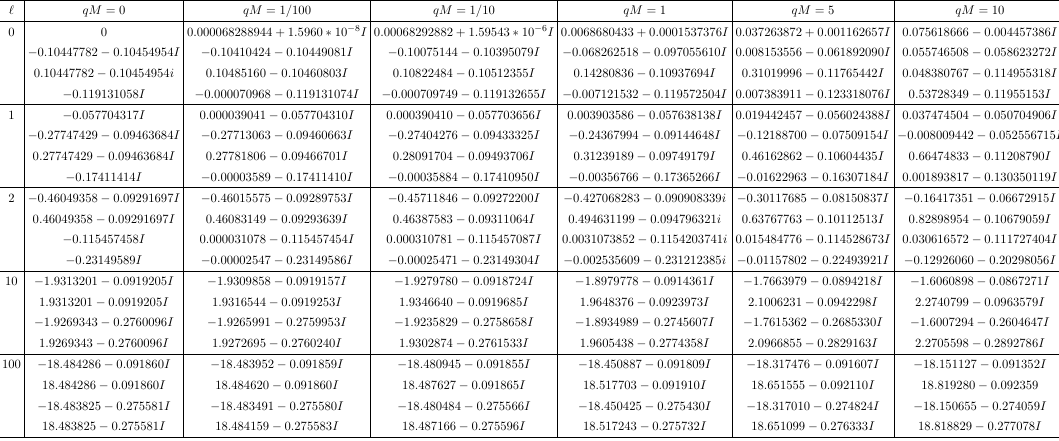
Table 3 . The QNFs ωM for massless charged scalar fields in the background of RNdS black holes with Λ M 2 = 0 . 01 , Q/M = 1 / 10 , and different values of ‘